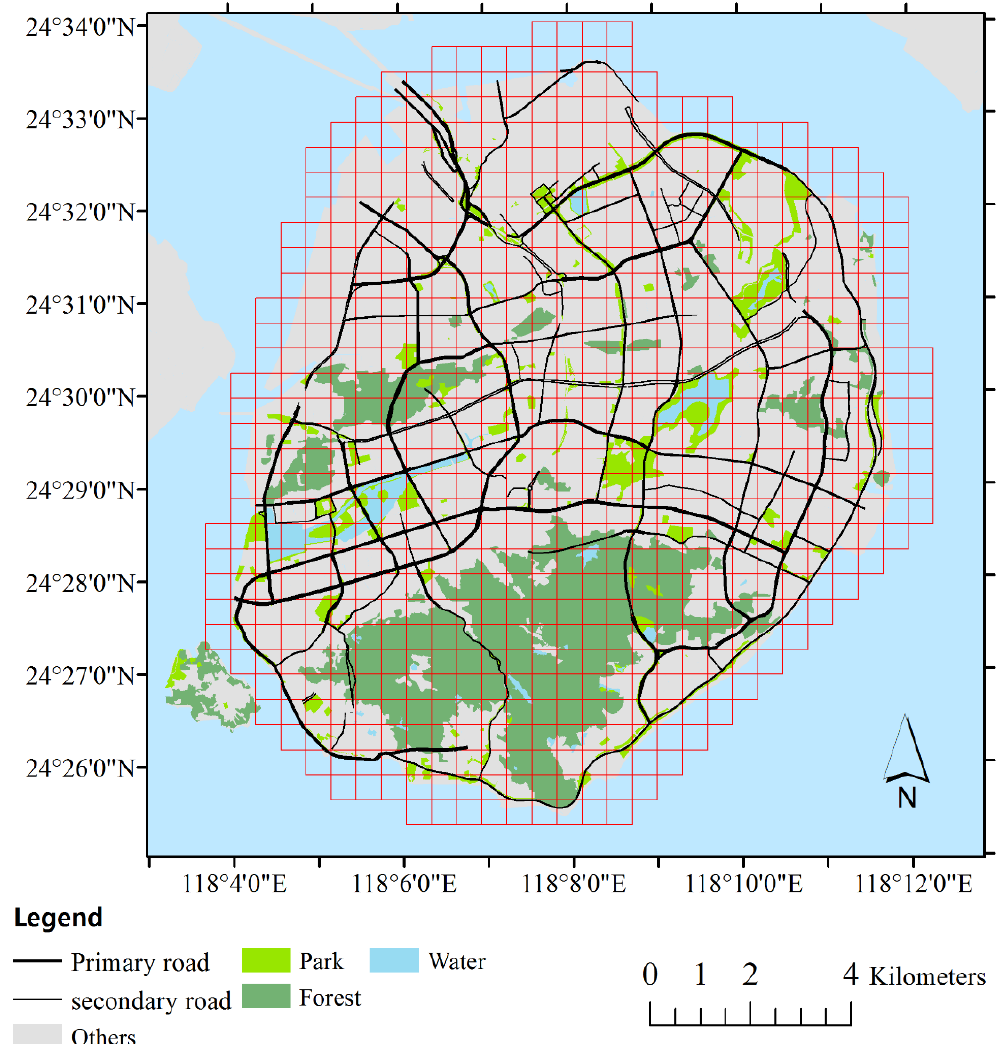
Figure 2. Location and grid-based segmentation of Xiamen Island.